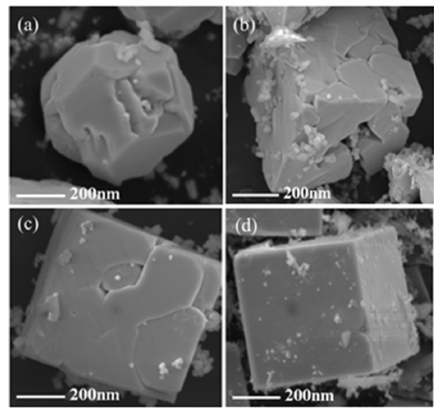
Figure 2. SEM images of BFO nanoparticles with different precursor pH values: ( a ) pH = 8; ( b ) pH = 10; ( c ) pH = 12; ( d ) pH ≥ 14.